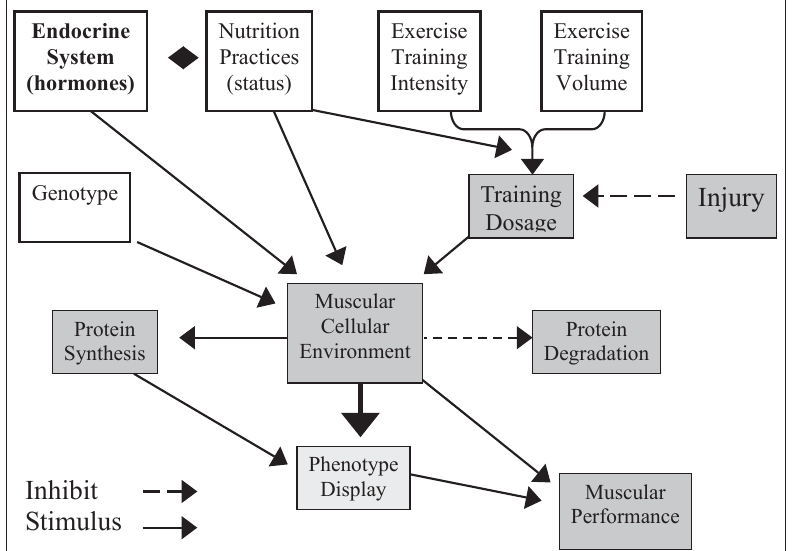
Figure 2. Schematic representation of the plasticity model of adaptation and the critical components which influence skeletal muscle myo-plasticity (modified from Brooks et al.,